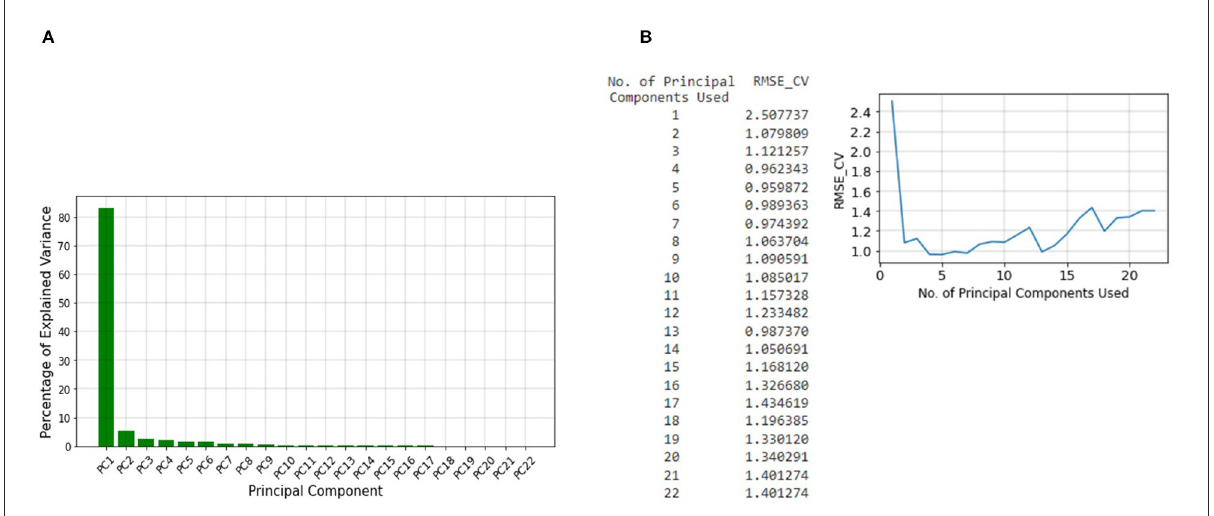
FIGURE3 (A) The percentage of explained variances for the different principal components, (B) Cross-validation RMSE for linear regression with different number of